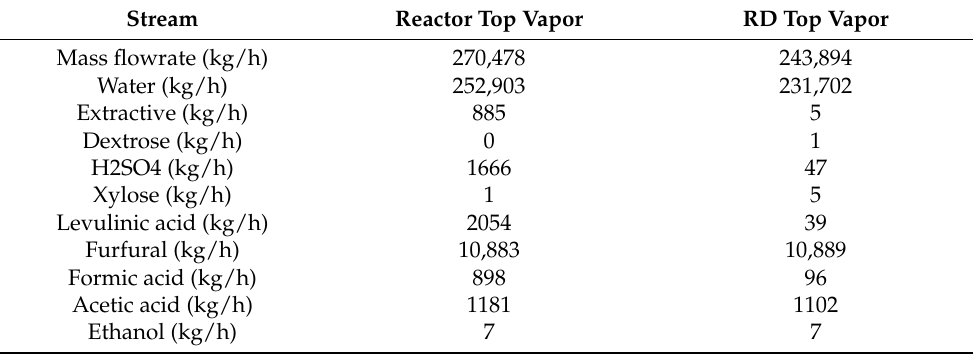
Table 3. Component flowrates of the top vapors of the reactor and reactive distillation. Stream Reactor Top